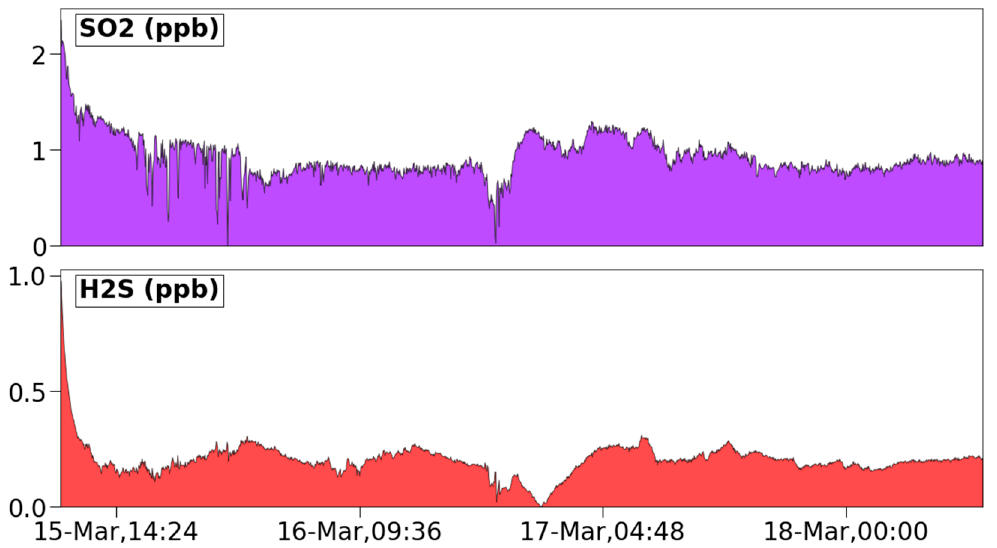
Figure 3. Concentration of SO 2 and H 2 S over time in the engine room during the same measuring campaign as shown in Figure 2. The 3-min data give the false impression of a meaningful trend. The measured concentrations with a faint variation between 0 and 2 ppb are close to the detection limit of the